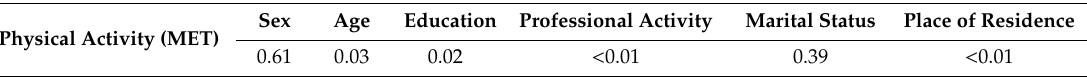
Comparative analysis of physical activity (MET) depending on sex, age, and sociodemographic